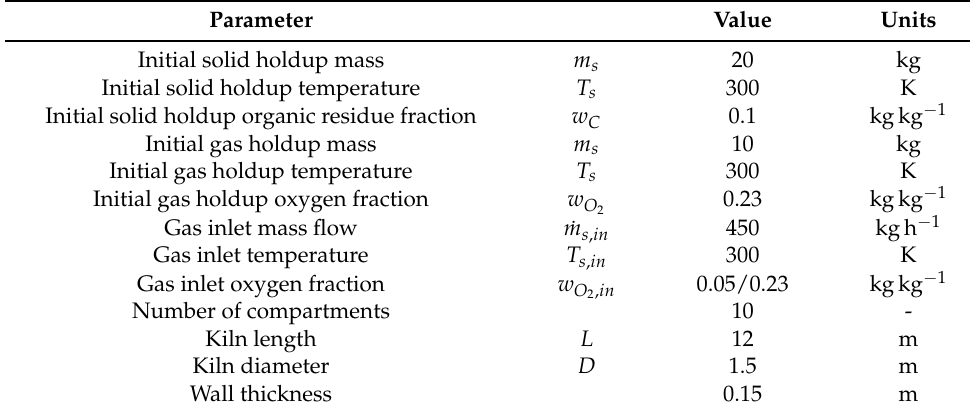
Table A8. Model parameters of the Calciner 1/Calciner 2 units used in the flowsheet simulations of the zeolite catalyst production